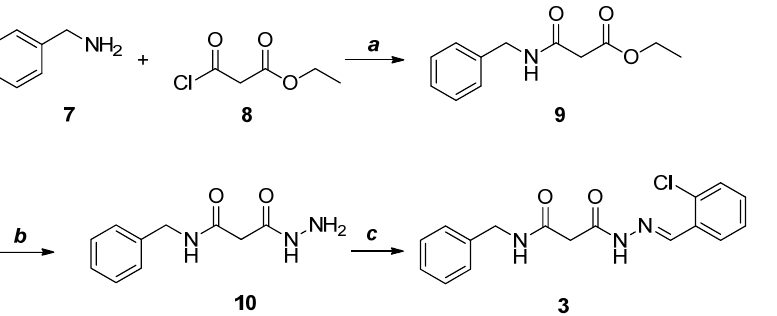
Table 1. Inhibitory action of the tested compounds on the cyt bc 1 function by measurements of the mitochondrial NADH:cyt c oxidoreductase